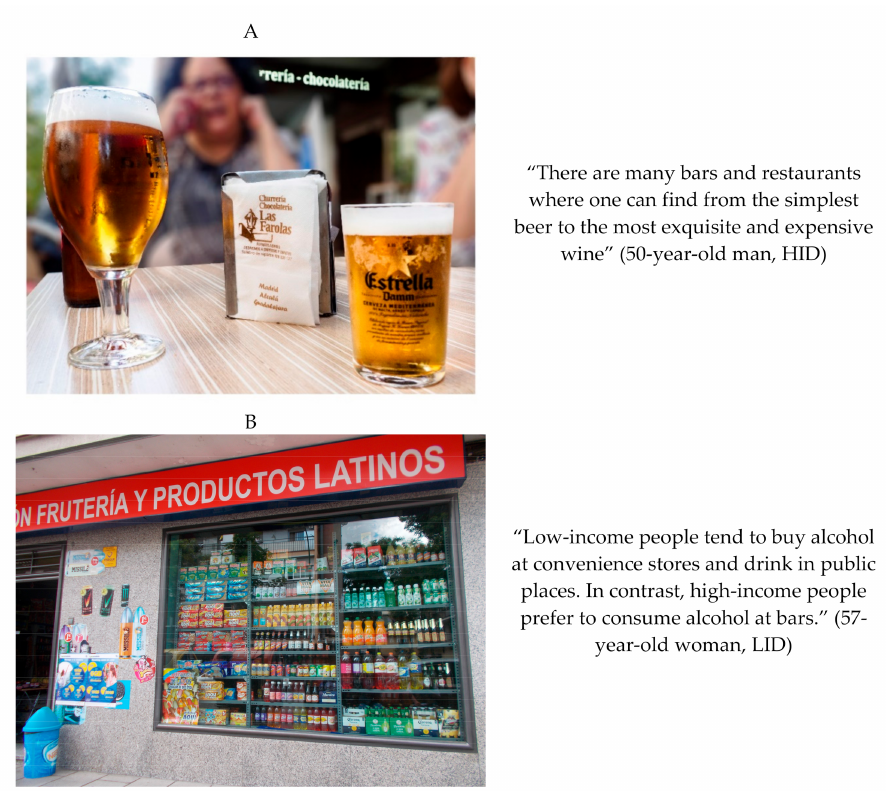
Figure 2. ( A ) Perceived alcohol availability in a high-income level neighborhood. Photograph: “If you don’t sell alcohol, you don’t sell”. ( B ) Perceived alcohol availability in low-income level neighborhood. Photograph: “A tolerated vice”. Examples of the availability results obtained in the high-income district (HID, Chamber í ) ( A ) and in the low-income district (LID, Villaverde) ( B ) through Photovoice.